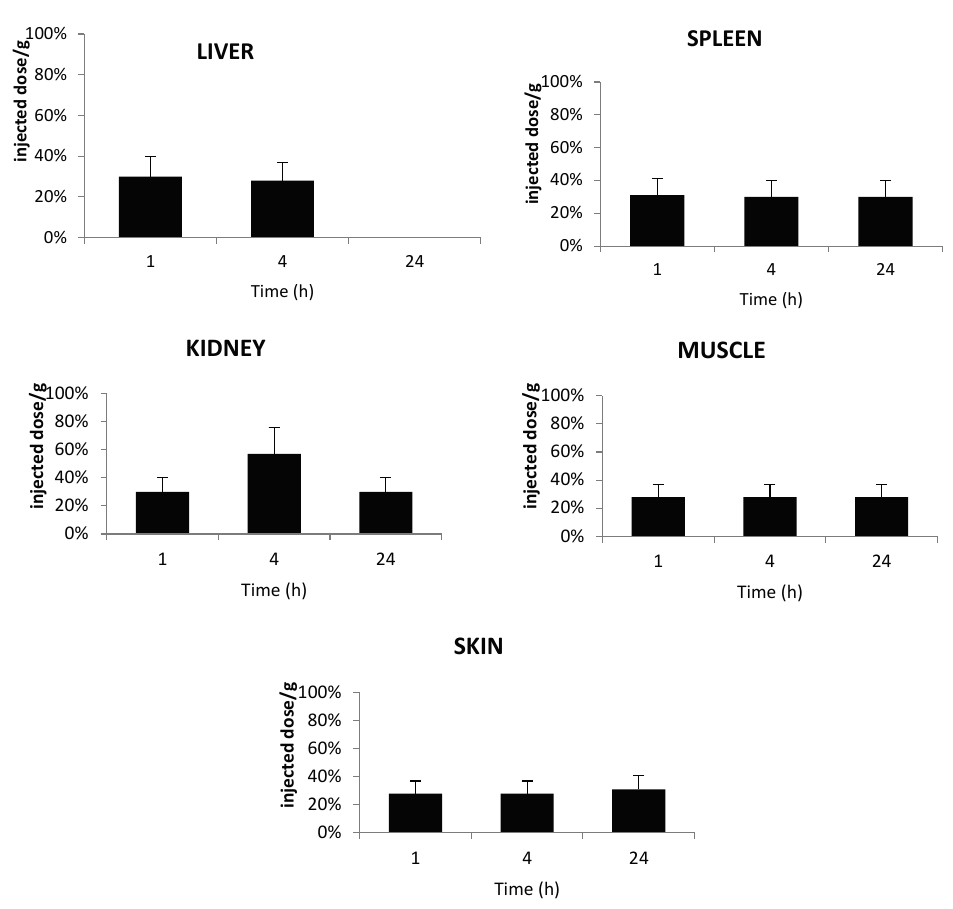
Figure 8. In vivo concentrations of TPC–PEG18–DKPPR in the liver, kidneys, spleen, muscle and skin of healthy mice. Concentrations were determined by HPLC analysis and were expressed as the percentage of injected dose per gram plasma at one, 4 and 24 h after the intravenous injection of 2.8 mg/kg (data points show the mean ± S.D., n ≥